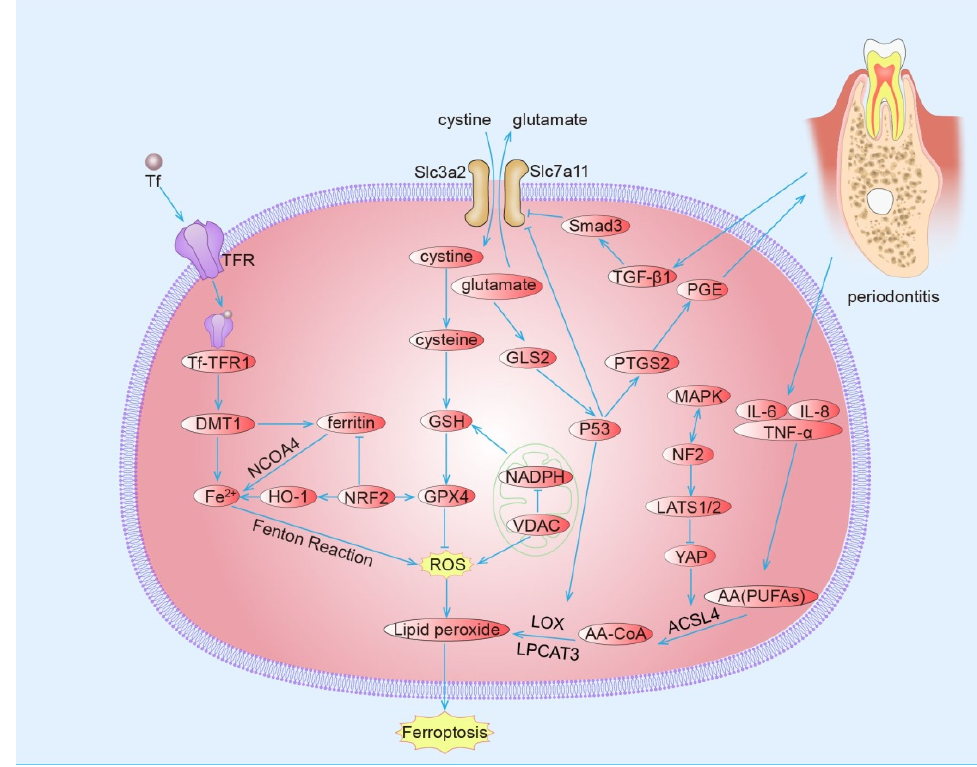
Figure 1. The related mechanism of ferroptosis and periodontitis. Glutamate acid and cystine are exchanged in a ratio of 1:1 inside and outside cells, and cystine is reduced to participate in GSH synthesis, activate GPX4, and inhibit ROS production. When VDAC was opened, NADPH production increased, which provided reduced hydrogen for GSH formation but increased ROS production. Tf combines with Tfr and merges into cells, and is introduced into the cytoplasm by DMT1, and exists in two forms of ferritin and free iron. Ferritin autophagy occurs through NCOA4, which increases the content of free iron, causes Fenton reaction and increases ROS. Under oxidative stress, NRF2 initiates the expression of GPX4, HO-1 and ferritin heavy chain, but at the same time, HO-1 can decompose heme to produce ferrous iron. P53 not only inhibits the expression of SLC7A11 but can also target PTGS2, promote prostaglandin synthesis, and damage periodontium. Glutamate was prepared by hydrolysis of glutamine catalyzed by GLS2. LOX promotes the formation of lipid peroxidation in cells. MAPK pathway and hippo pathway promote each other, NF2 activates hippo, activates LATS1/2, phosphorylates YAP and inhibits the expression of downstream ACSL4. In periodontitis, inflammatory factors IL-6, IL-8 and TNF- α can promote the deposition of unsaturated fatty acids, which are acylated by AcSL4, integrated to cell membrane by LPCAT3, and become an important substance of iron death after being oxidized by LOX. TGF- β 1 during periodontal bone formation can inhibit the expression of SLC7A11 through Smad3. Abbreviations—Tf, transferrin; TFR, transferrin receptor; DMT1, divalent metal ion transporter 1; NCOA4, nuclear receptor coactivator 4; OH-1, heme oxygenase-1; NRF2, nuclear factor erythroid 2-related factor 2; GSH, glutathione; GPX4, glutathione peroxidase 4; ROS, reactive oxygen species; NADPH, nicotinamide adenine dinucleotide phosphate; VDAC, voltage-dependent anion channel; TGF- β 1, transforming growth factor- β 1; PG, prostaglandin; PTGS2, prostaglandin-endoperoxide synthase 2; LOX, lipoxygenase; LPCAT3, phospholipid choline acyltransferase 3; AA(PUFAs), arachidonic acid (Polyunsaturated fatty acids); AA-CoA, arachidonic acid-coenzyme A; ACSL4, acyl-Coa synthase long-chain family member 4; NF2, neurofibromatosis 2; YAP, Yes-associated protein; MAPK, mitogen-activated protein kinase; TNF- α , tumor Necrosis Factor- α ; IL, interleukin; Smad3, Small mothers against decapentaplegic.